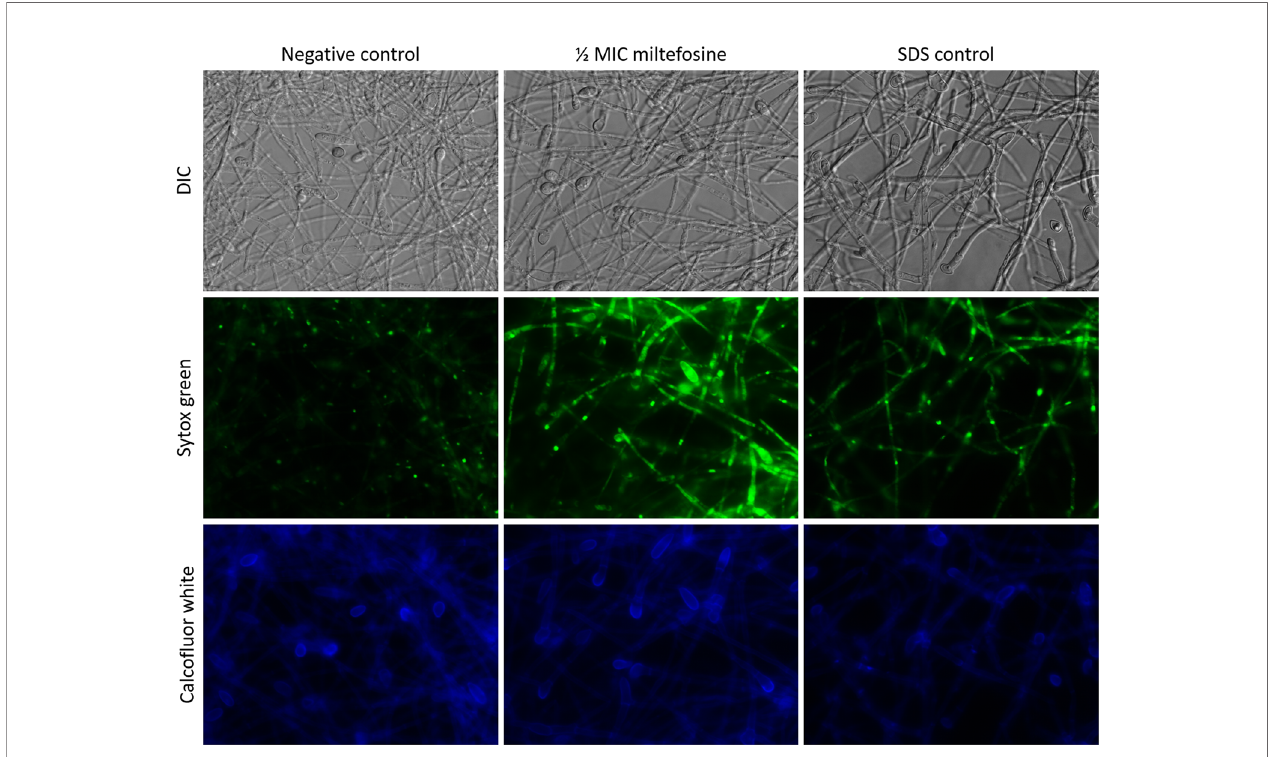
FIGURE 10 | Fluorescence microscopy of Scedosporium aurantiacum cells grown for 24 h at 37°C in the absence (negative control) or the presence of 0.5× MIC (2.0 m g/ml) of miltefosine. Sodium dodecyl sulphate (SDS) was used as a positive control of permeable membrane. Cells were stained with Sytox Green, which interacts with nucleic acid of permeable cells, and calco fl uor white that stains the fungal cell wall. MIC, minimum inhibitory concentration.